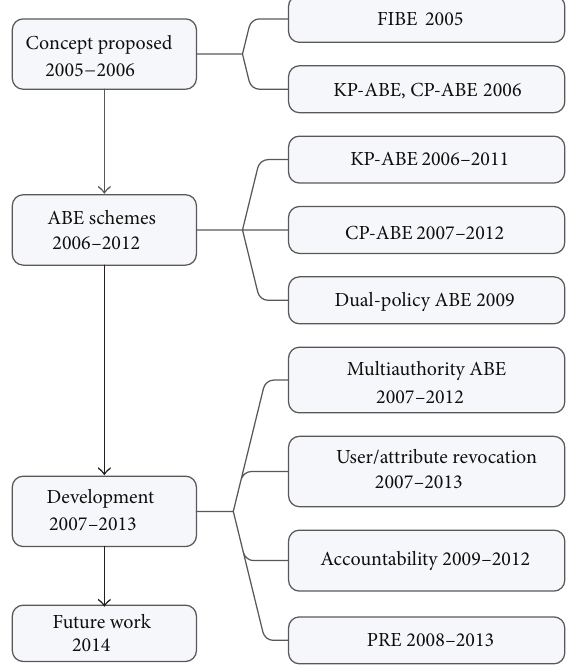
Figure 1: Development of